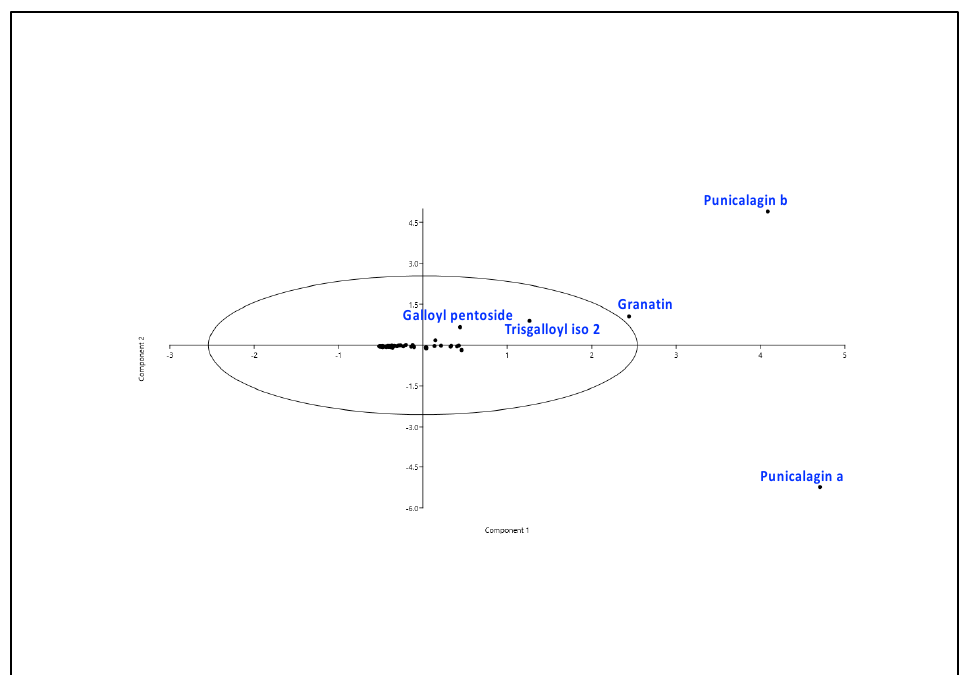
Figure 4. Principal component analysis (PCA) of the metabolites of M1-M14 peel samples. Compo- nent 1 and 2 explained, respectively, 77.8% and 14.4% of the total variance.